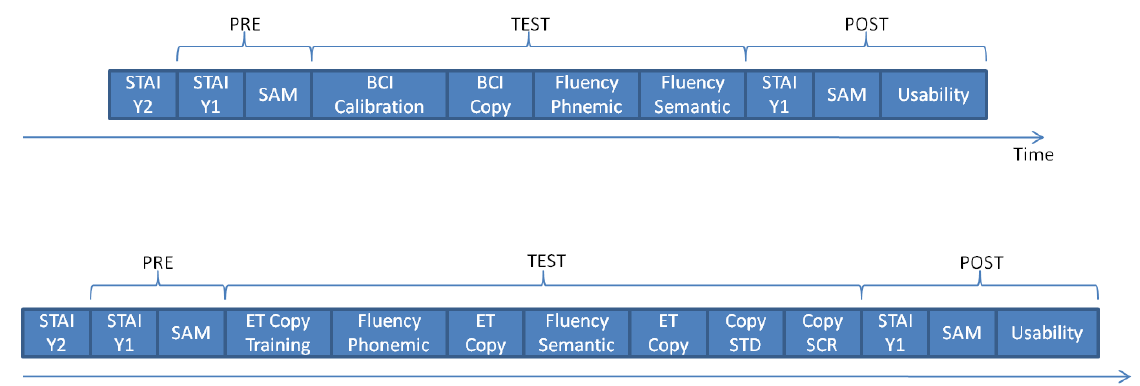
Figure 2. Experimental procedure timeline for both BCI and ET sessions